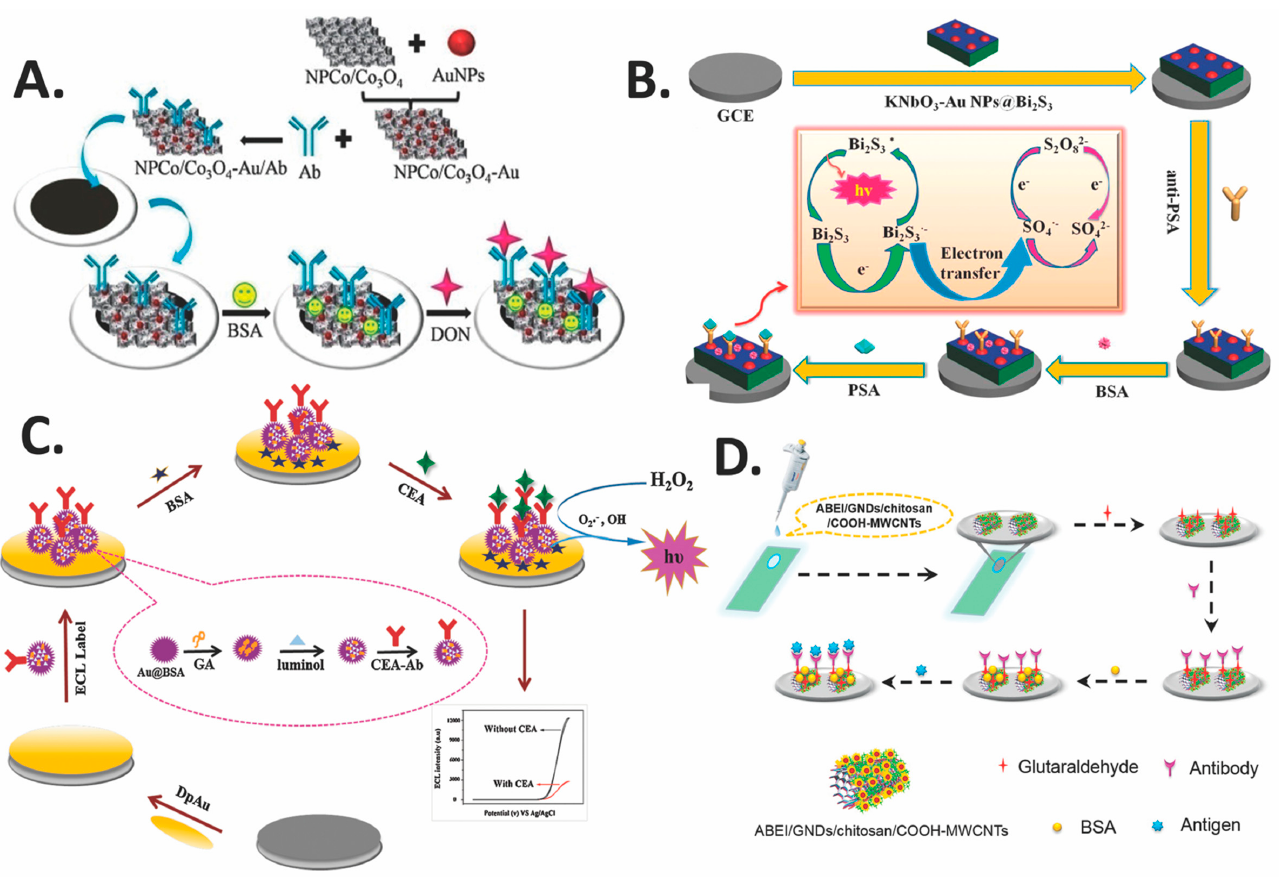
Figure 7. AuNPs nanocomposite-based ECL nanobiosensors: ( A ) ECL nanobiosensor with gold functionalized nonporous CO/Co 3 O 4 . Reprinted from Ref. [14] with permission from Elsevier; ( B ) ECL nanobiosensor incorporating the nanocomposite of KNbO 3 -AuNPs@Bi 2 S 3 . Reprinted from Ref. [70] with permission from Elsevier; ( C ) ECL nanobiosensor utilizing the nanocomposite of Au@BSA. Reprinted from Ref. [67] with permission from Elsevier; and ( D ) ECL nanobiosensor with ABEI/GNDs/chitosan/COOH-MWCNTs. Reprinted from [71] with permission from the American Chemical